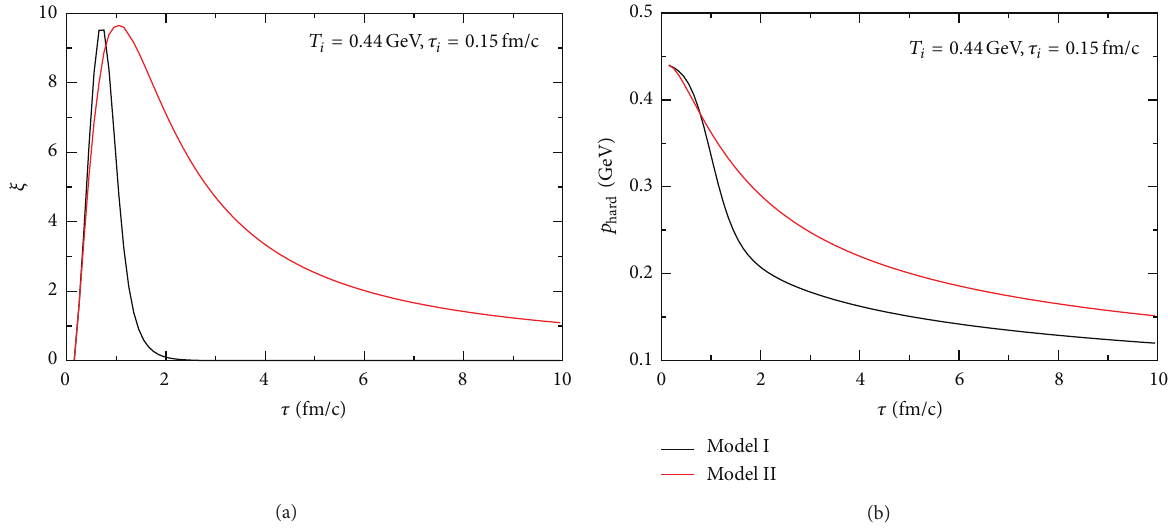
in the two space-time hard